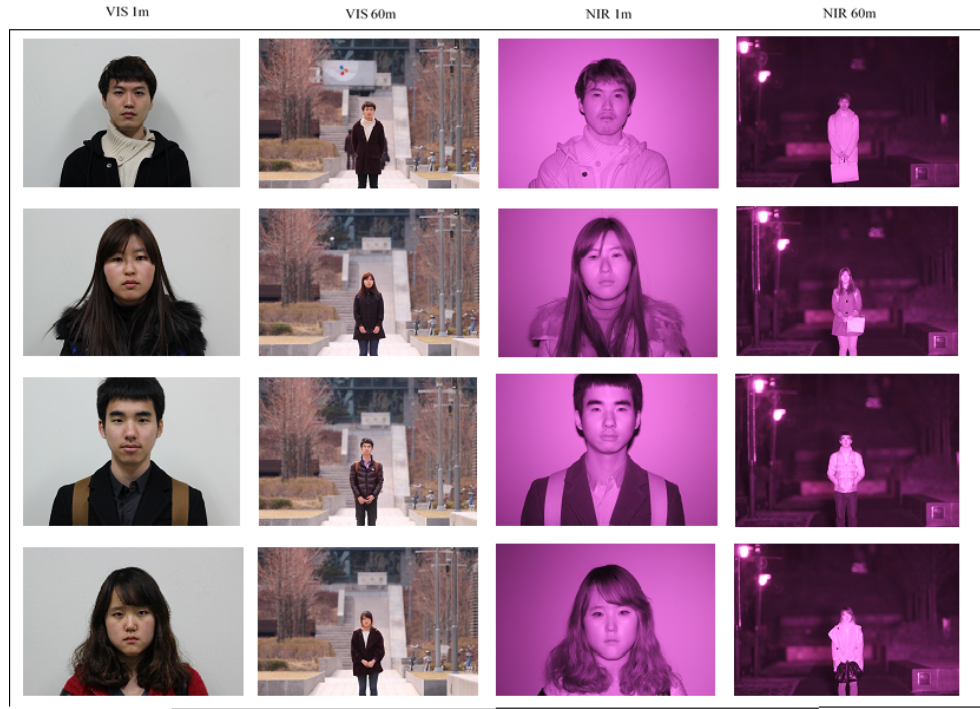
Figure 3. The sample of NIR and VIS face images captured at 1m and 60 m